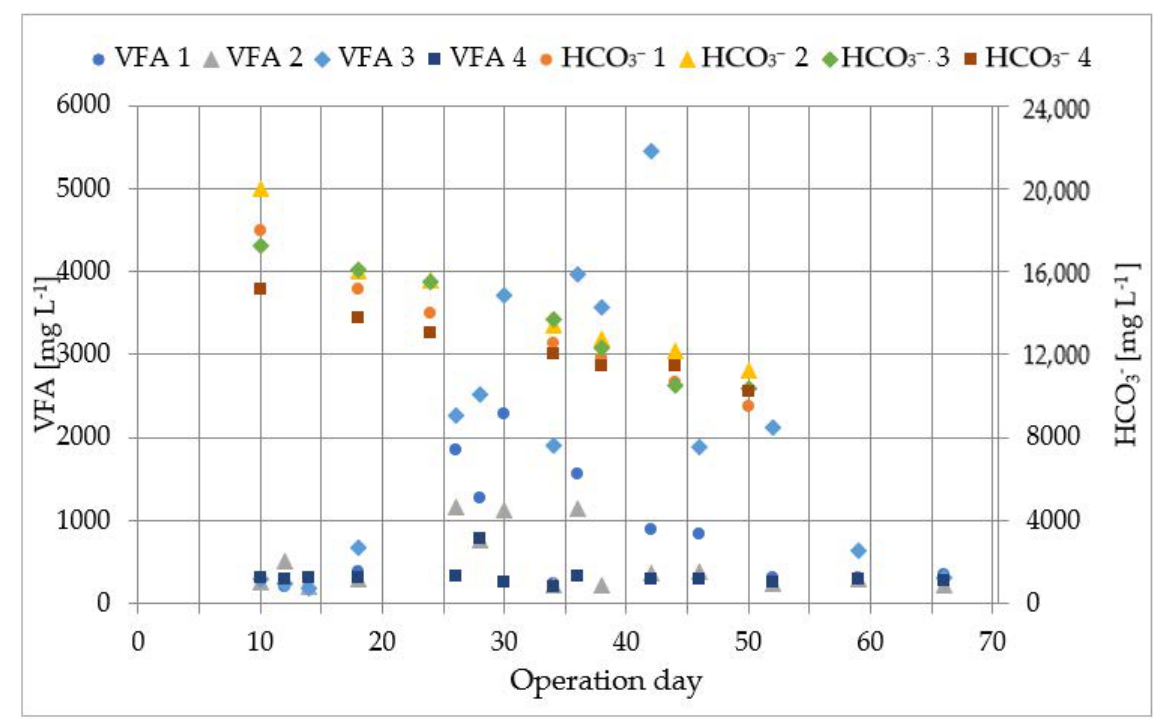
Figure 15. Results of VFA and HCO 3 − analyses in all